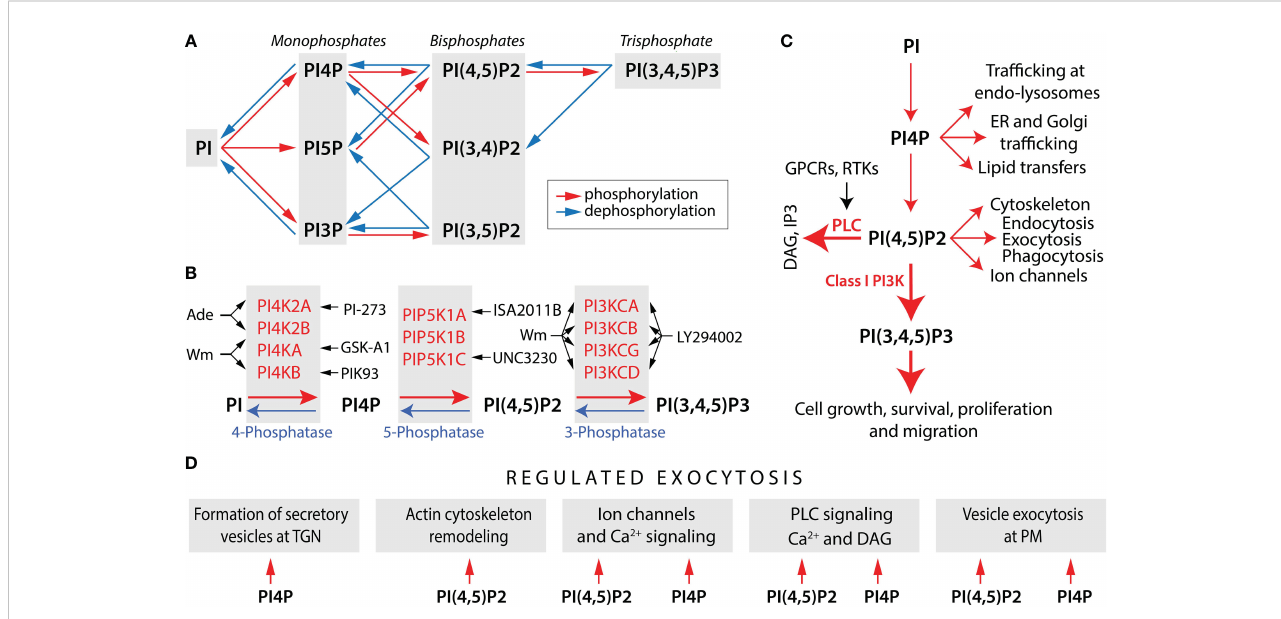
FIGURE 1 Phosphoinositide metabolism and functions. (A) Schematic representation of phosphoinositide metabolism. The concerted actions of PI-kinases (red arrows) and PI-phosphatases (blue arrows) generate three monophosphates, three bisphosphates, and a single trisphosphate. For simplicity, reactions that are likely to predominate in vivo are shown. (B) PI-kinases and PI-phosphatases involved in the metabolism of PI4P, PI(4,5)P2, and PI (3,4,5) P3 and kinase inhibitors discussed in this review. Black arrows indicate the enzymes inhibited by drugs. Wortmannin (Wm), a fungal metabolite, is a cell-permeable and irreversible inhibitor of phosphatidylinositol 4-kinases PI4KA and PI4KB, both in a micromolar concentration range (1), whereas PI4K2A and PI4K2B are inhibited by adenosine (Ade) (2). PI4KA is speci fi cally inhibited by GSK-A1 and PI4KB by PIK93 (3), whereas PI4K2A is inhibited by PI-273 (4). The activity of PIP5K1A is blocked by ISA2011B (5) and PIP5K1C by UNC3230 (6). PI5P also contribute to the formation of PI (4,5) P2 by PI4K2A/B, which are inhibited by Bay-091 and Bay-297 (7). PI(4,5)P2 is a